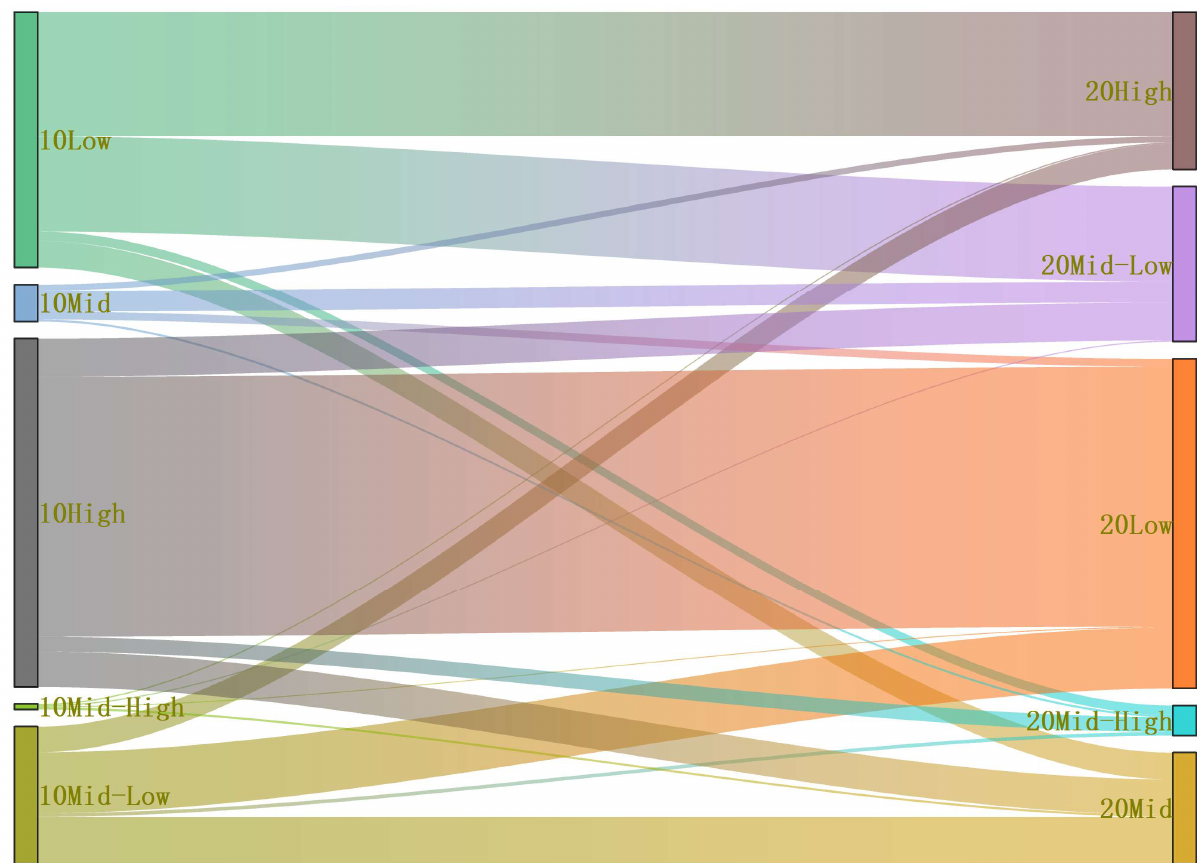
Figure 9. Sankey map of area transfer of ecological risk at different levels from 2010 to 2020.